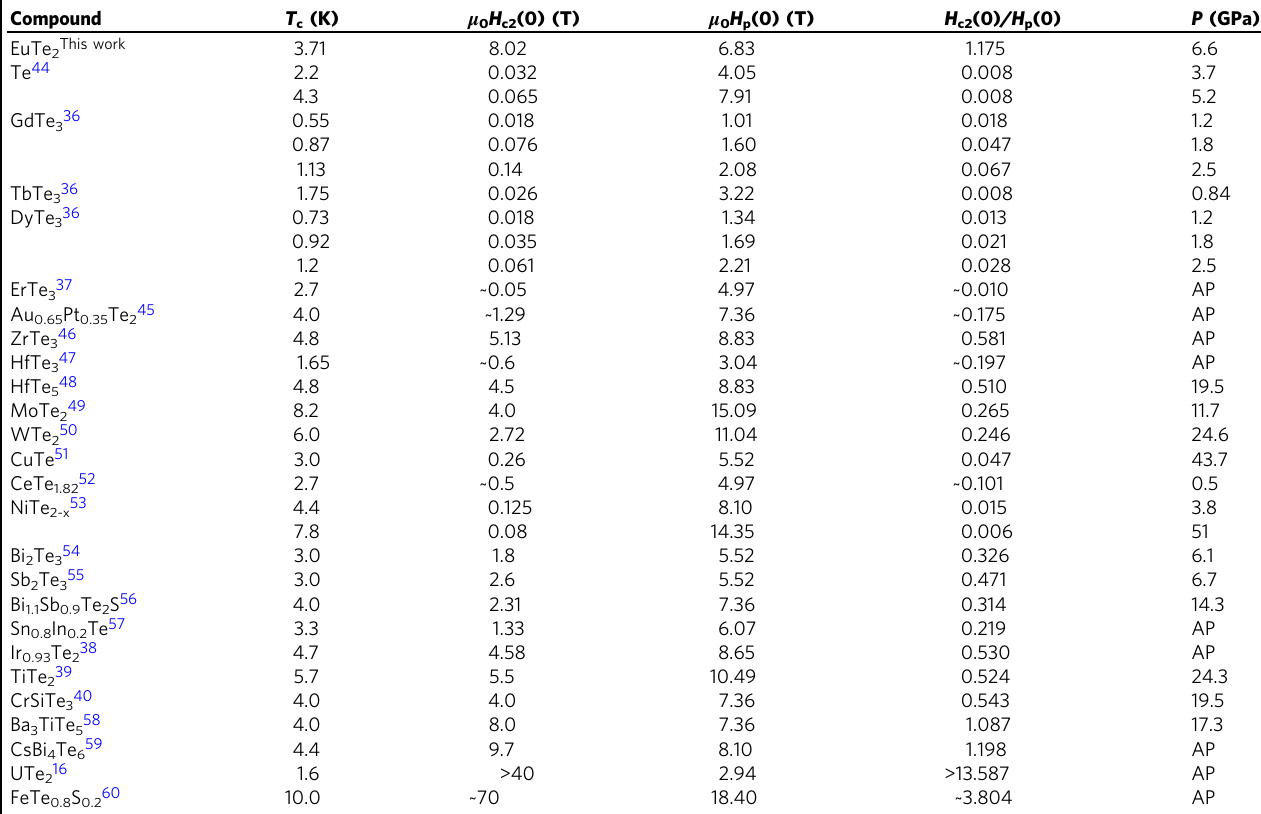
Table 1 Summary of the superconducting transition temperature T c and the upper critical fi elds μ 0 H c2 (0) for the reported Te-containing